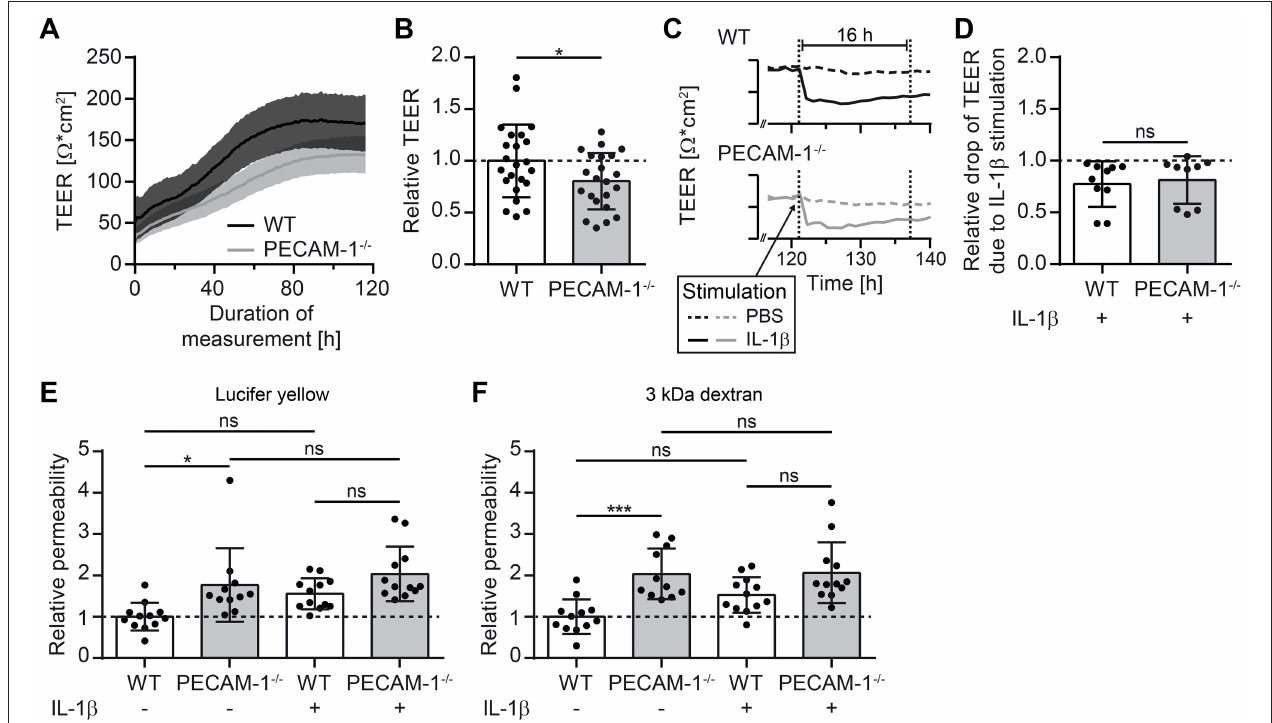
FIGURE 4 | PECAM-1 − / − pMBMECs exhibit impaired barrier properties. (A) Transendothelial electrical resistance (TEER) of pMBMECs grown on filter inserts was measured by impedance spectroscopy using the cellZscope ® (nanoAnalytics) starting 2 days after cell isolation over a period of 5 days in hourly intervals. Solid lines (black, WT; gray, PECAM-1 − / − ) represent mean values and shaded areas represent SEM calculated from 6 filter inserts with WT pMBMECs and 5 filter inserts with PECAM-1 − / − pMBMECs, respectively. One representative experiment out of three is shown. (B) Relative TEER of WT and PECAM-1 − / − pMBMECs was calculated from maximal TEER of each filter insert with WT set to 1.0. Graph combines three independent experiments (WT, 23 filter inserts; PECAM-1 − / − , 22 filter inserts). Dots represent individual data points; error bar ± SD. Reported statistics result from unpaired, two-tailed Student’s t -test. Test statistics: p = 0.042, t (43) = 2.096, d = 0.639. (C) Exemplary TEER curves for PBS- and IL-1 β -treated WT and PECAM-1 − / − pMBMEC monolayers are shown. Dashed lines, PBS-treated filter inserts; solid lines, IL-1 β -treated filter inserts; dotted vertical lines, 16h time window of stimulation. (D) Relative drop of TEER indicating the decrease of electrical resistance 16h after stimulation (final concentration of 20ng/ml IL-1 β per insert) normalized to genotype-matched PBS-treated filter inserts. Dots represent individual data points; error bar ± SD. Reported statistics result from unpaired, two-tailed Student’s t -test. Test statistics: p = 0.714, t (17) = 0.373, d = 0.181. (E,F) Relative permeability coefficient of the two different sized fluorescent tracers Lucifer yellow (457 Da) (E) and Alexa-Fluor-680-conjugated 3 kDa dextran (F) across WT and PECAM-1 − / − pMBMEC monolayers normalized to the mean WT value. Data are derived from four independent experiments (WT, 12 filter inserts; PECAM-1 − / − , 11 to 12 filter inserts). Dots represent individual data points; error bar ± SD. Reported statistics result from one-way ANOVAs with Sidak’s multiple comparisons test. Test statistics: (E) F (3, 43) = 6.382, p = 0.0011, η 2 = 0.308; (F) F (3, 43) = 9.375, p < 0.0001, η 2 = 0.395; * p < 0.05; *** p < 0.001; ns, not